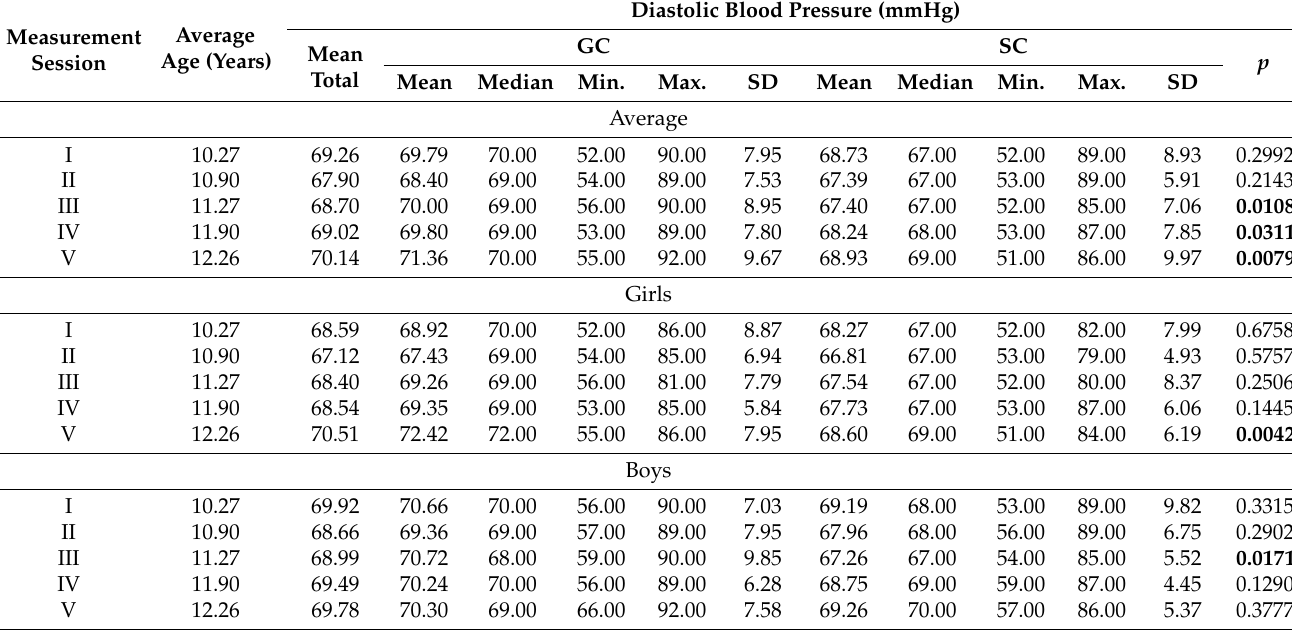
Table 3. The mean diastolic blood pressure in children during the course of the study